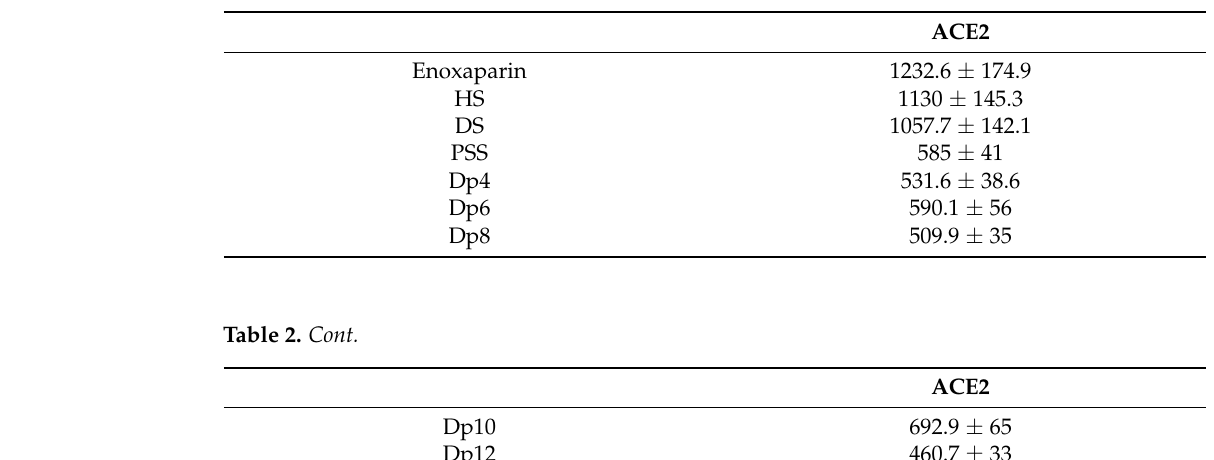
Table 1. Kd values (nM) for Spike FL and Spike RBD to different GAG variants.